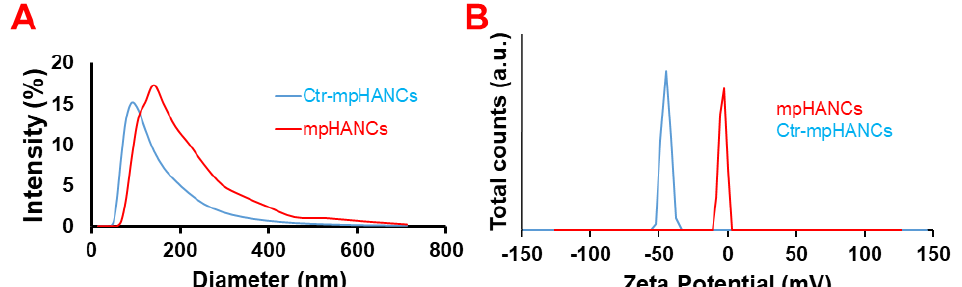
Figure 2. Zeta size ( A ) and zeta potential ( B ) of mpHANCs and Ctr–mpHANCs.